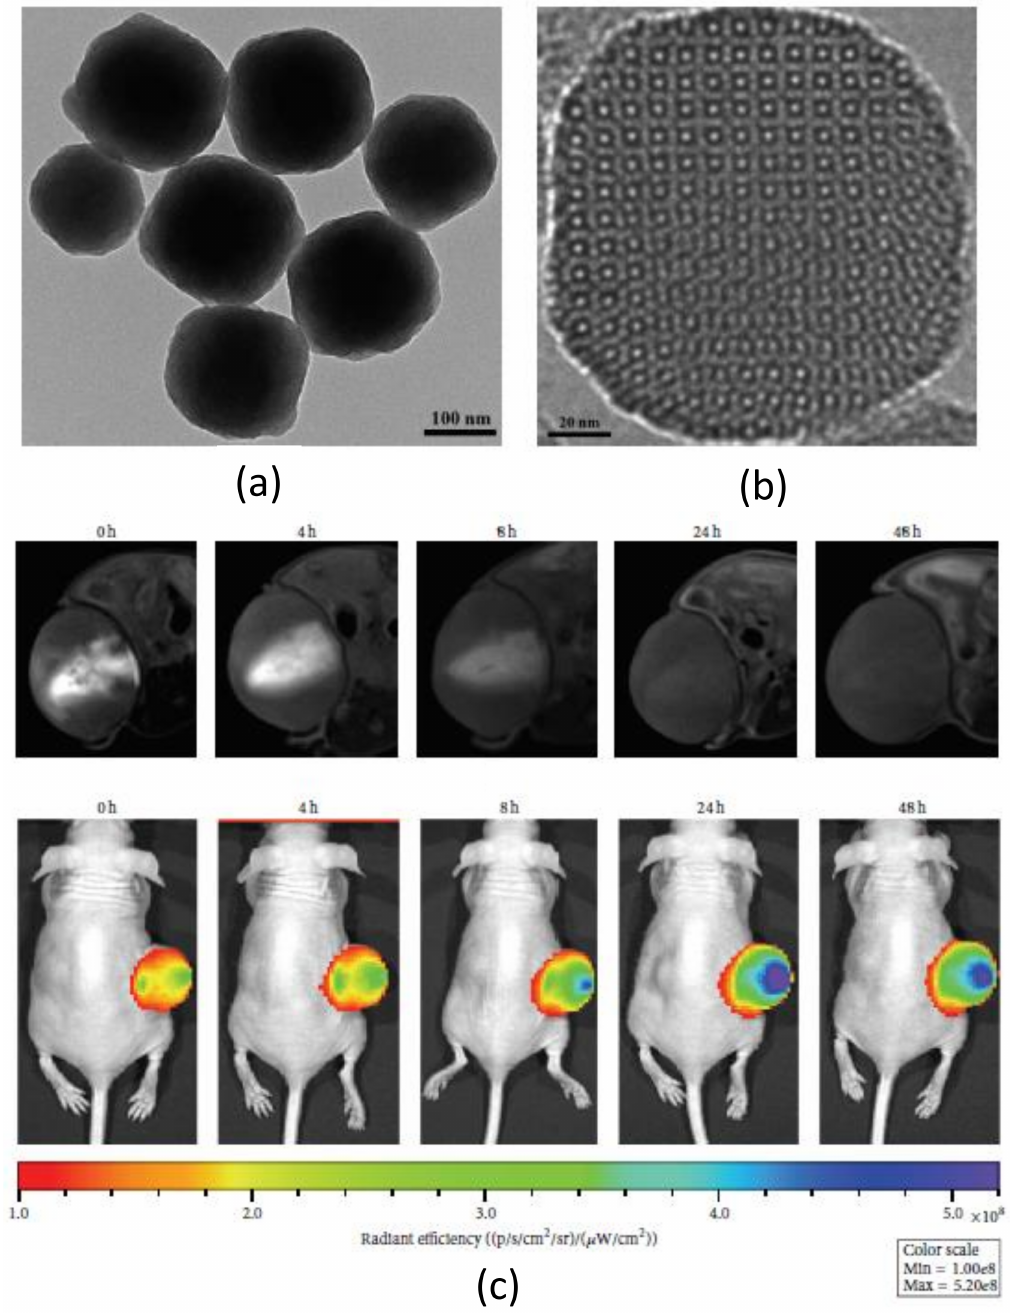
Figure 8. ( a , b ) TEM images of the aminated mesoporous silica nanoparticles synthesized by CTAB-directed sol-gel processes using TEOS and APTES as co-precursors; ( c ) in vivo dual-modality imaging (MR and NIR fluorescence) of U87-MG tumor- bearing mouse model after intratumoral injection of Gd/NIR-MSNs at 0, 4, 8, 24, and 48 h. Figure adapted from [79], Copyright 2016 Hindawi